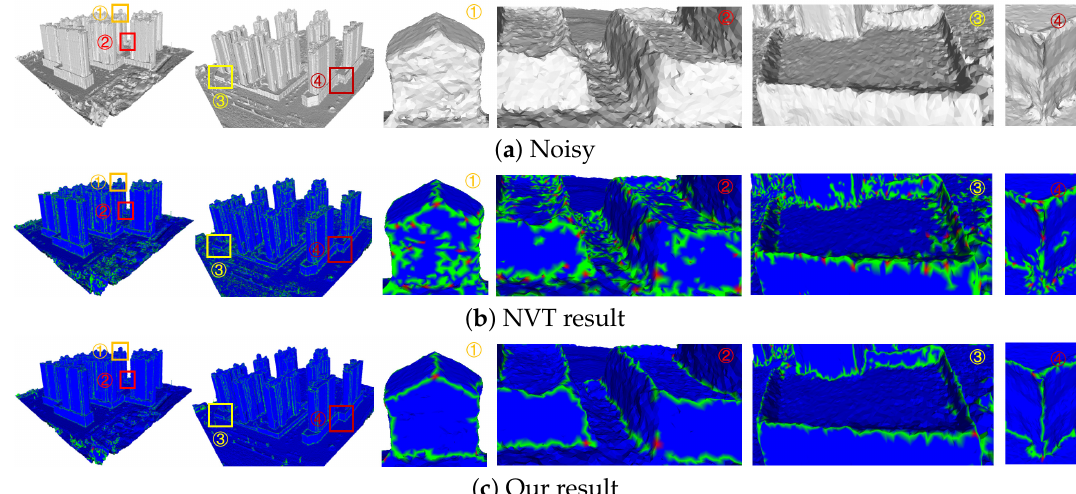
Figure 12. Comparison of feature point classification results for the City model reconstructed from oblique images.